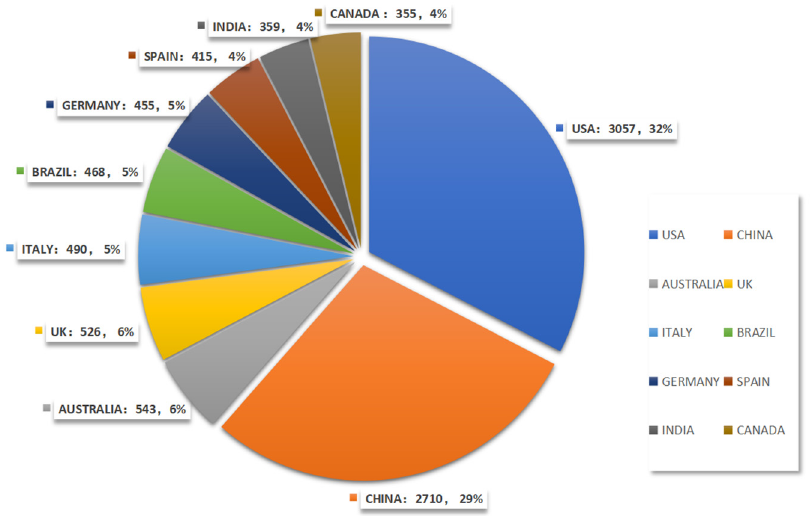
Figure 5. Research output by country in the field of urban land management in Web of Science from 1979 to 2021.